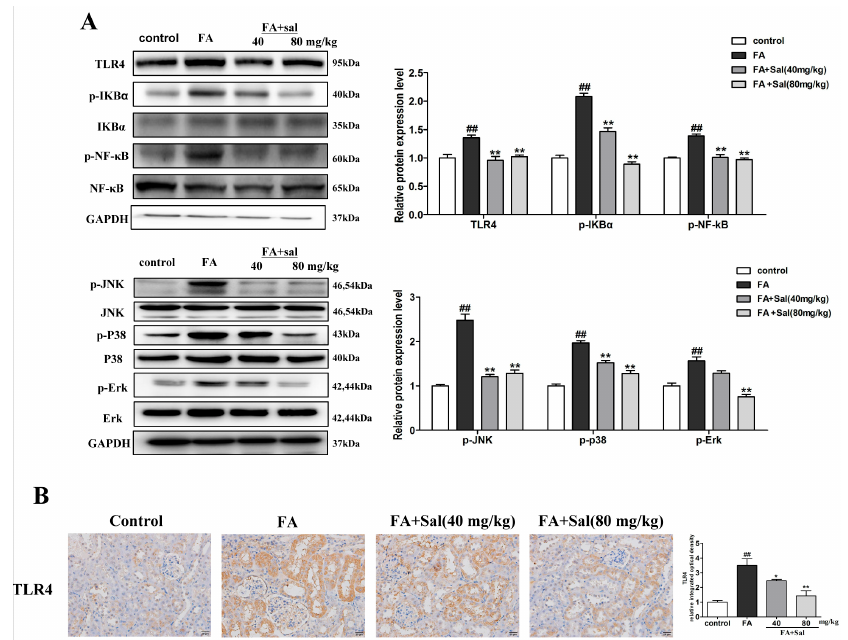
Figure 5. Sal suppresses renal inflammation via the TLR4/NF- κ B and MAPK signaling pathways in mice. ( A ) Western blot analysis of TLR4, p-I κ B α , p-NF- κ B, p-P38, p-ERK, and p-JNK protein FA mice. ( A ) Western blot analysis of TLR4, p-I к B α , p-NF- κ B, p- Ρ 38, p-ERK, and p-JNK protein